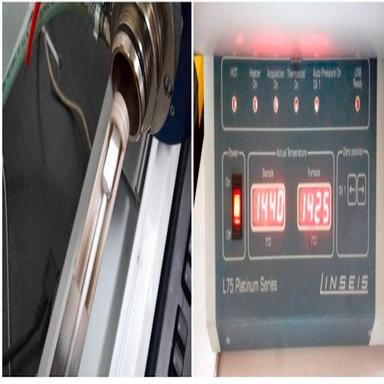
CTE measurement set-up: view of horizontal dilatometer L75HX1600 in opened configuration with the sample inserted, the thermocouple and the alumina push-rod (left), device display showing sample and furnace temperatures (right).